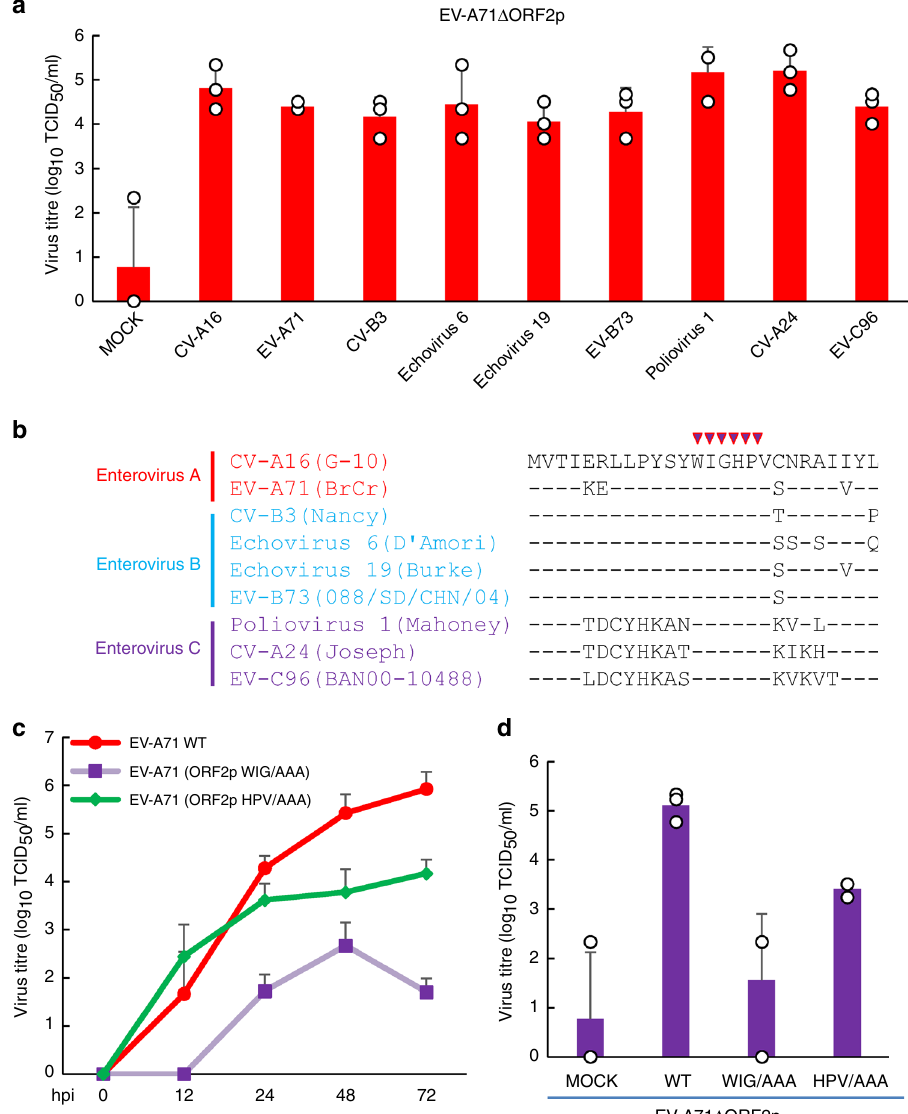
Fig. 3 The WIGHPV domain of ORF2p from enteric enteroviruses is important for viral infection in HT-29 cells. a HT-29 cells expressing the ORF2p protein derived from CV-A16, EV-A71, CV-B3, Echovirus 6, Echovirus 19, EV-B73, Poliovirus 1, CV-A24 and EV-C96 were infected with EV-A71 Δ ORF2p at an MOI of 0.1. Viral titres were determined at 72 hpi ( n = 3 biologically independent experiments). Error bars denote SEM. b Alignment of amino acid sequences of the N-terminal portion of ORF2p from human enteroviruses. Residues of WIGHPV are marked with red arrows. c HT-29 cells were challenged with EV-A71 and mutant viruses EV-A71 (ORF2p WIG/AAA) and EV-A71 (ORF2p HPV/AAA) at an MOI of 0.1. Viral titres were determined at 0, 12, 24, 48, and 72 hpi ( n = 3 biologically independent experiments). Error bars denote SEM. d Viral titres of HT-29 cells expressing wild-type ORF2p, WIG/AAA, or HPV/AAA; control cells were infected with EV-A71 Δ ORF2p. Viral titres were determined at 72 hpi. Error bars denote SEM, n = 3 biologically independent